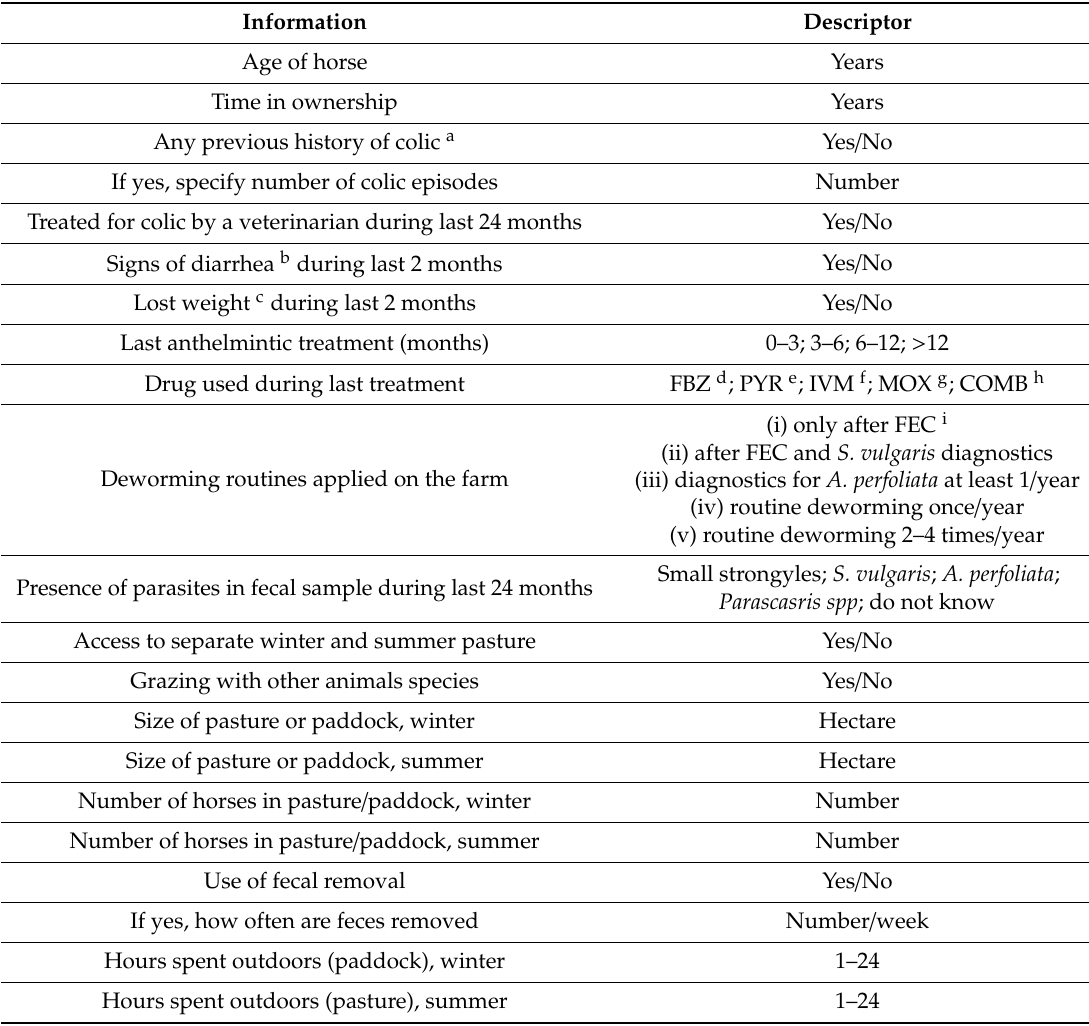
Table 1. Questionnaire data collected from participating cases and